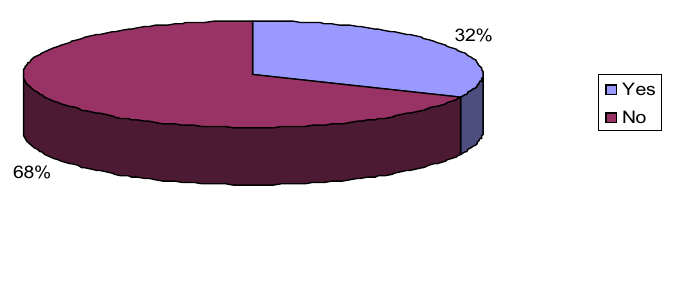
Figure 2 . Teaching staff training on ODeL